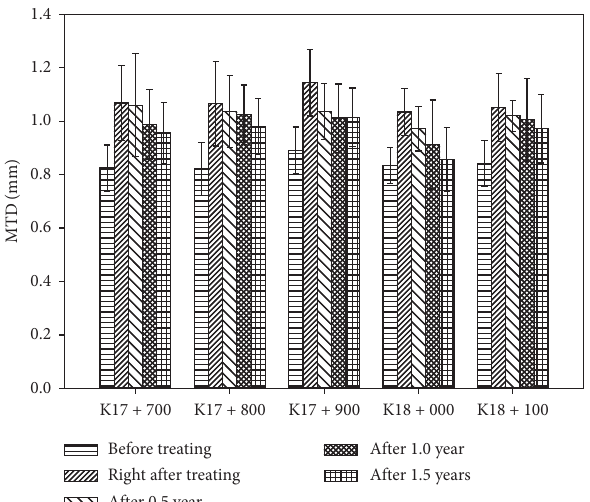
Figure 9: MTD values of pavement surface before and after sand fog seal.